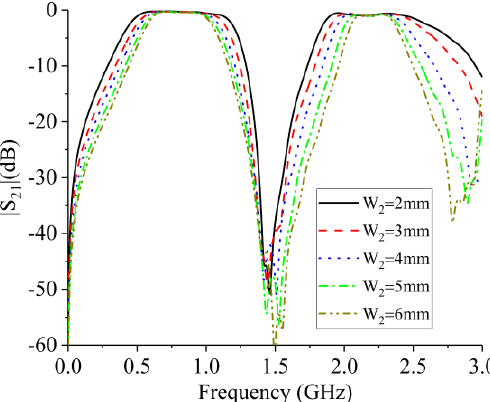
Figure 9. Simulated S 21 of the second-order dual-band bandpass filter with different W 2 , L 1 = 34 mm, and L 2 = 38 mm ( W s 1 = W s 2 = W 2 ).